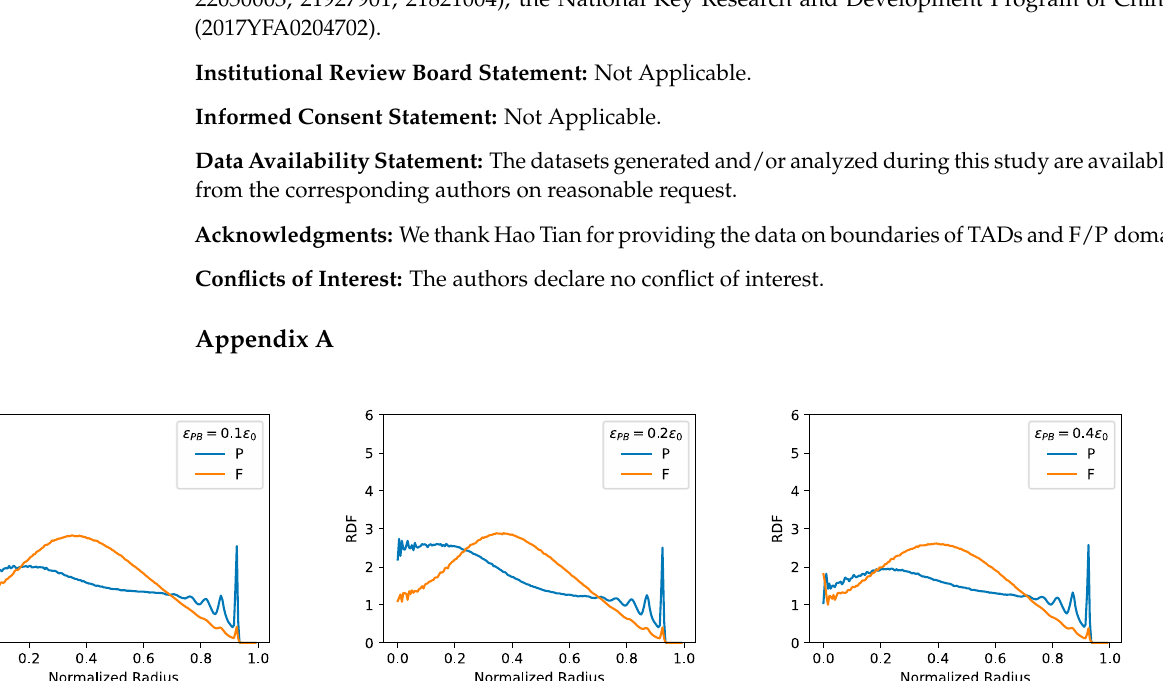
. Figure A2. FF and PP contact probability ( P ) as a function of sequential distance obtained from the 1-Chr system consid- ering different ε FF values. Figure A3. FF and PP contact probability ( P ) as a function of sequential distance obtained from the 1-Chr system consid- ering different ε PP values. References 1.